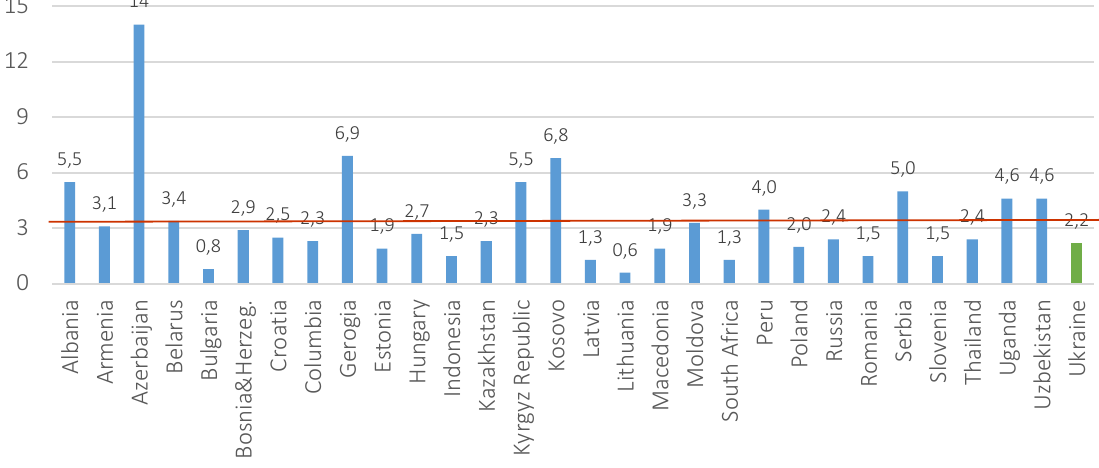
Figure 5. Public investments in Ukraine versus emerging market countries and countries average as a % of the GDP in